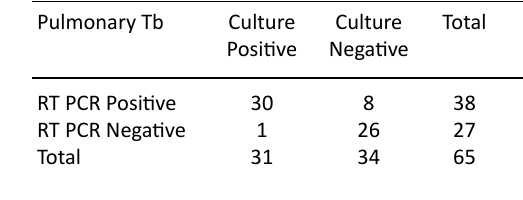
Table 3 . Comparison of Culture and RT PCR results in Pulmonary Tuberculosis